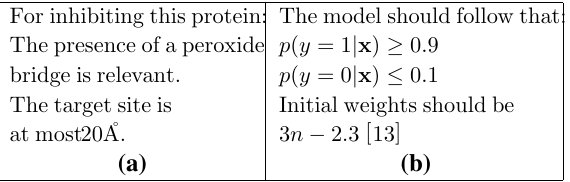
For inhibiting this protein: The model should follow that: The presence of a peroxide p ( y = 1 bridge is relevant.